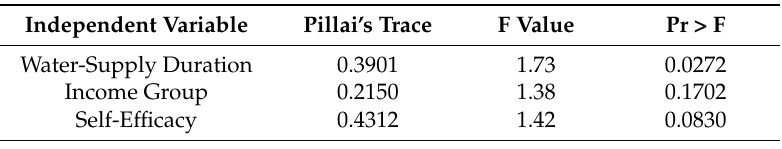
Table 7. Significant results of MANOVA model, based on Pillai’s Trace, after conducting backward elimination of other independent